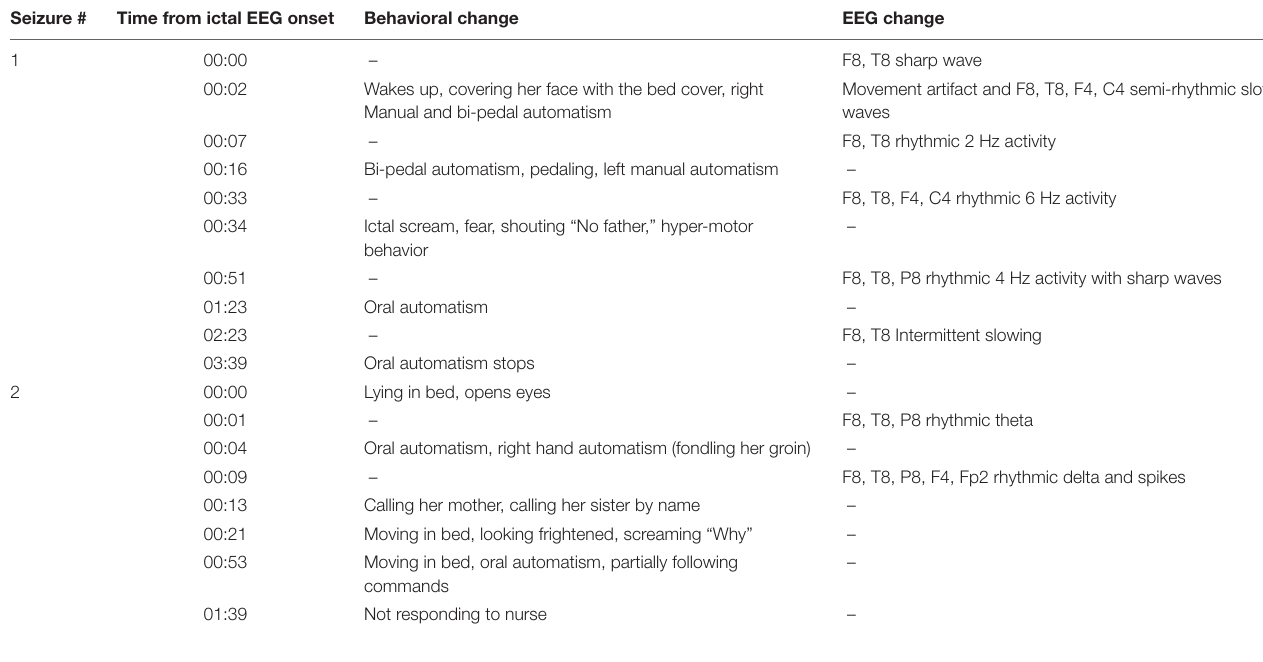
TABLE 1 | Clinical details of the ictal events recorded at the Epilepsy Monitoring Unit